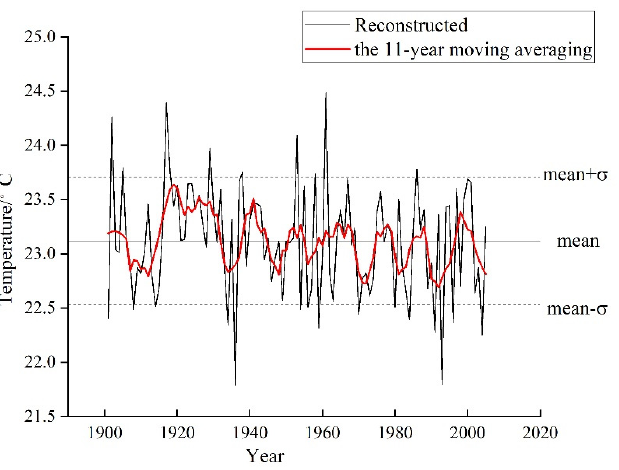
Figure 8. The reconstructed T MJ curve and 11-year moving average curve in the Tongbai Mountains from 1901 to 2005.